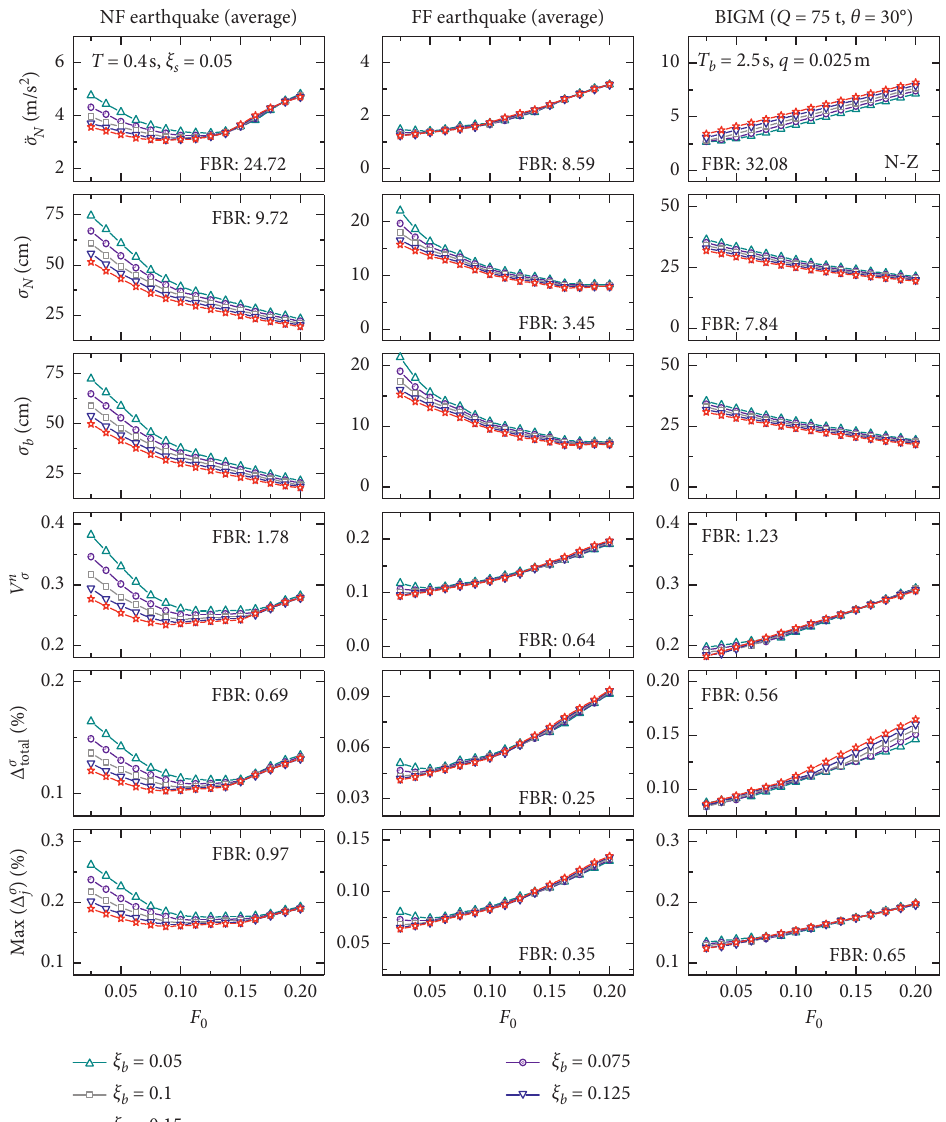
Figure 9: The effect of the normalized yield strength ( F isolated by the N-Z system under earthquake and